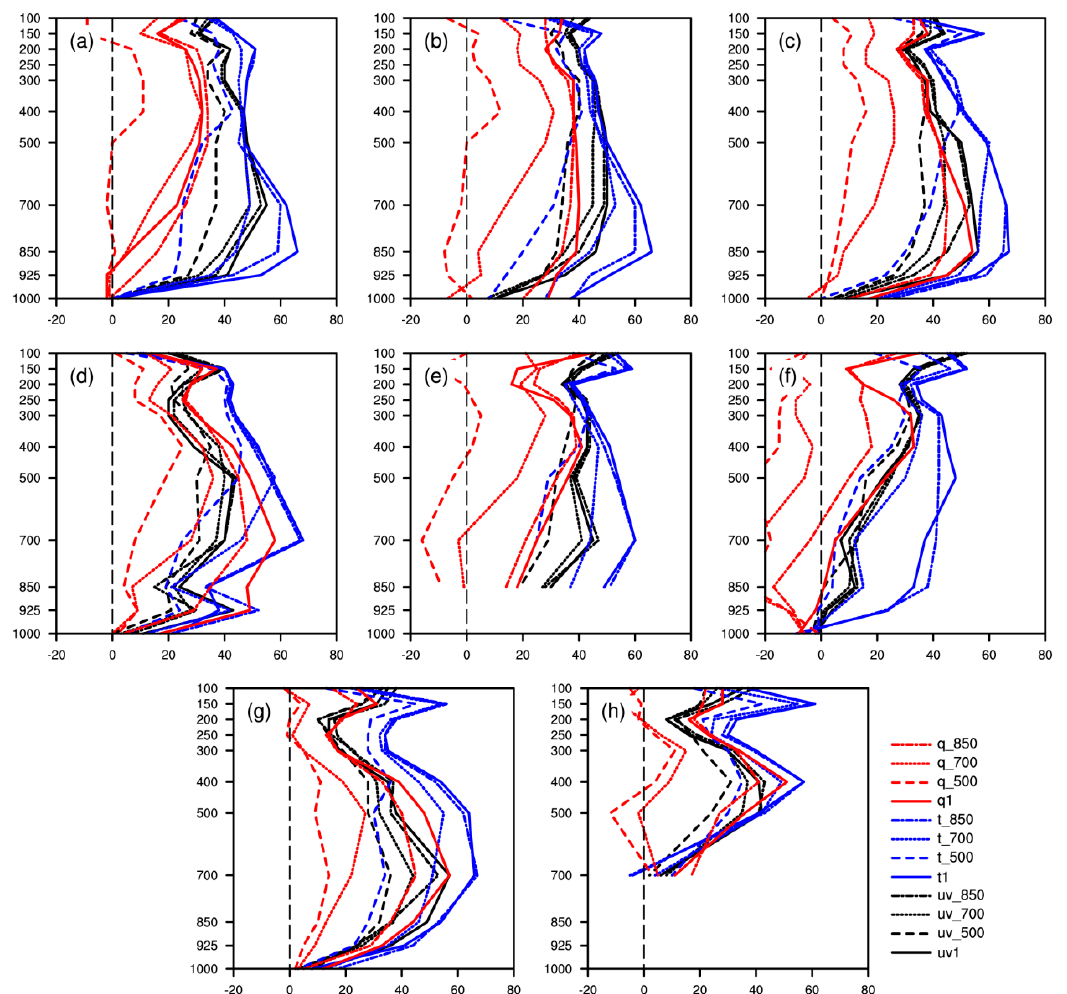
Figure 9. The variation of RATE (%) of simulated meteorological elements at standard sounding layers along with height (hPa) with different nudging levels: ( a ) Northeast China (A); ( b ) North China (B); ( c ) East China (C); ( d ) South China (D); ( e ) East of Northwest China (E); ( f ) West of Northwest China (F); ( g ) Southwest China (G); and ( h ) Tibet (H).